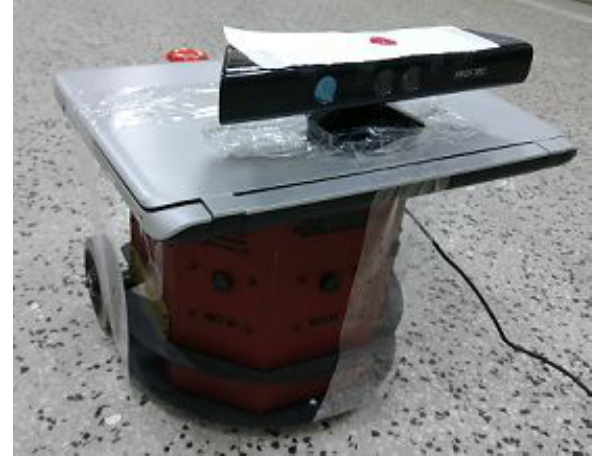
Figure 7: Robot Platform Used for Experiment. The Kinect has been attached to a Firebird 6